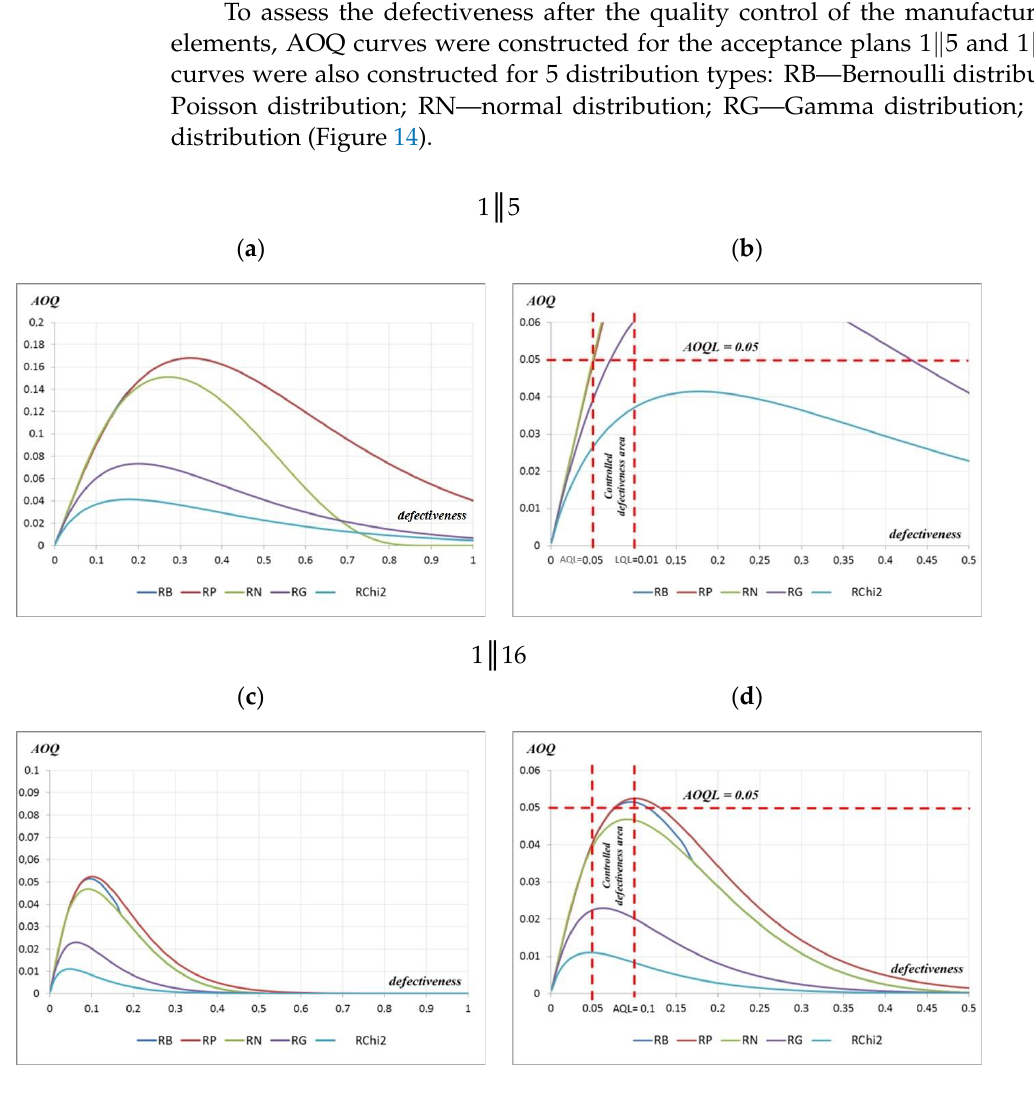
Figure 14. AOQ curves for testing plans: (a) 1 ║ 5 and (b) 1 ║ 5; 1 ║ 16 (c) 1 ║ 16 and (d) 1 ║ 16.